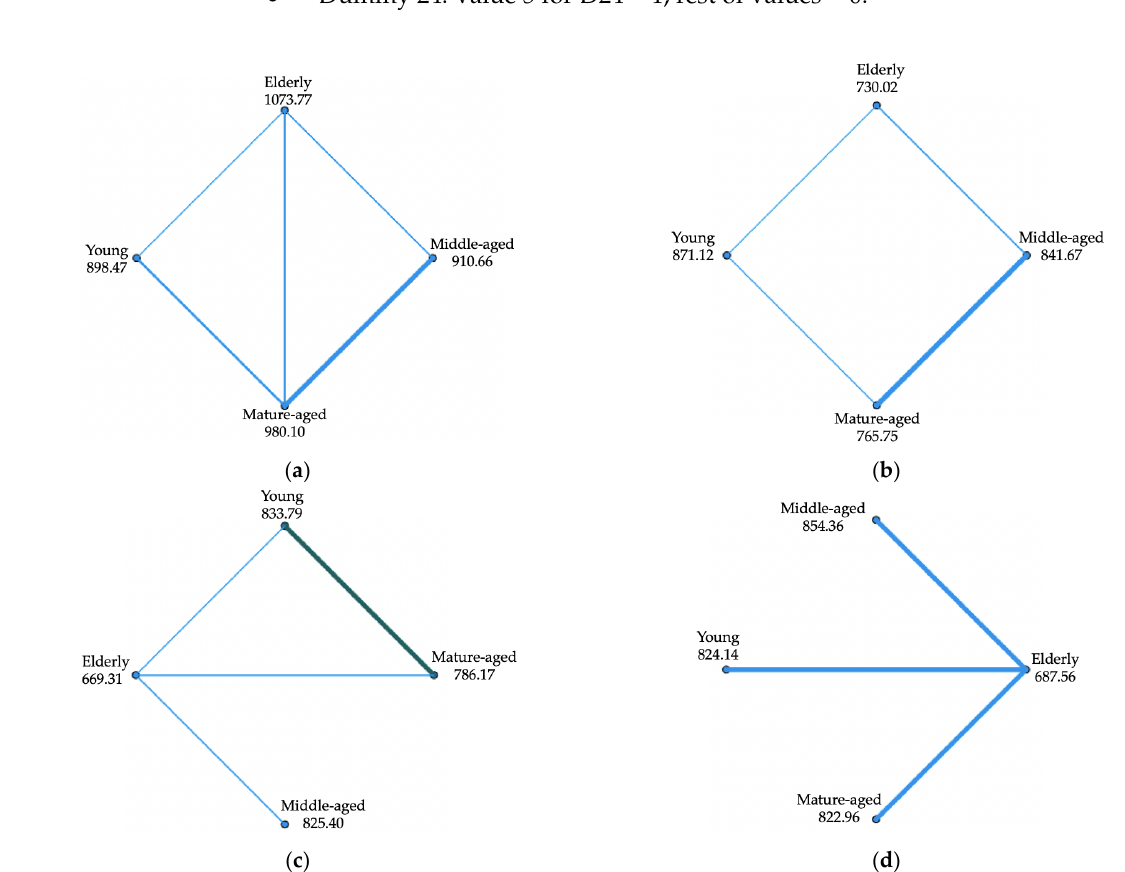
Figure 1. Pair comparisons. Categories of age of respondent: ( a ) D19: Do you think world ’ s climate is changing; ( b ) D22: Climate change caused by natural processes, human activity, or both? ( c ) D23: To what extent feel a personal responsibility to reduce climate change? ( d ) D24: How worried about climate change? All relations contrast tests with significance p < 0.1%. Table 4. Correlations between studied